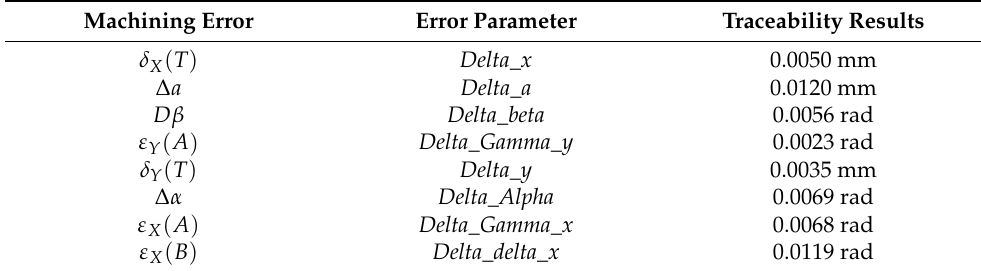
Table 6. Summary of actual error value and traceability